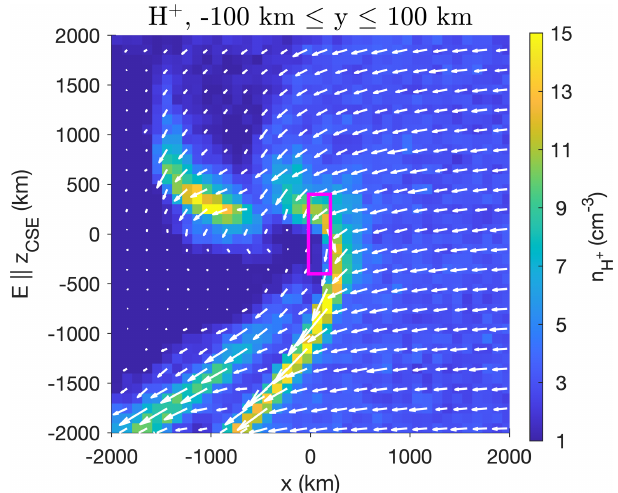
Figure 5. Density and direction of the flux of the protons from the hybrid simulations. The simulation was run for a case of Q = 3 . 2 × 10 27 s − 1 . For a more detailed list of parameters, see Gunell et al. (2018). Here, the Sun is to the right. The IBS is roughly located where the proton density reaches its highest values